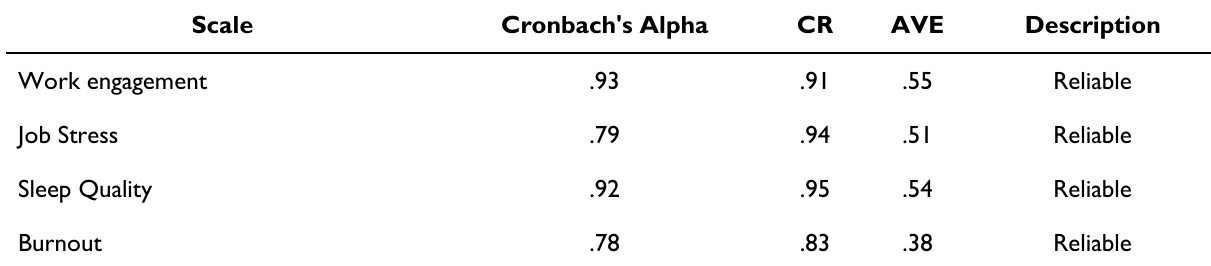
Table 4. Convergent Reliability-AVE